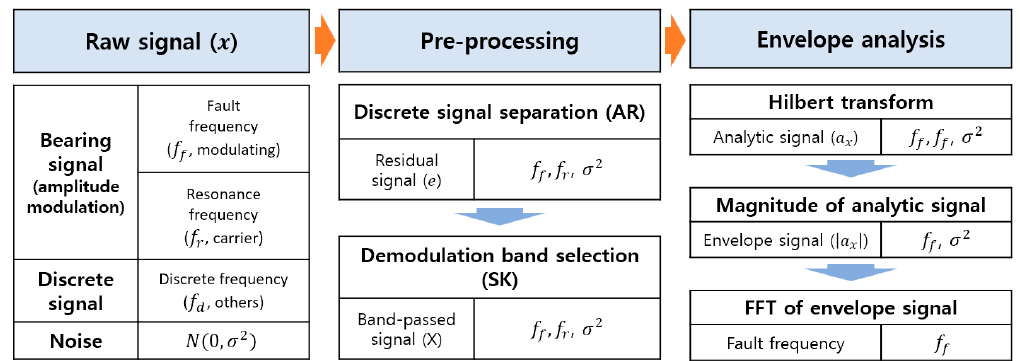
Figure 5. Procedure for bearing fault diagnosis.